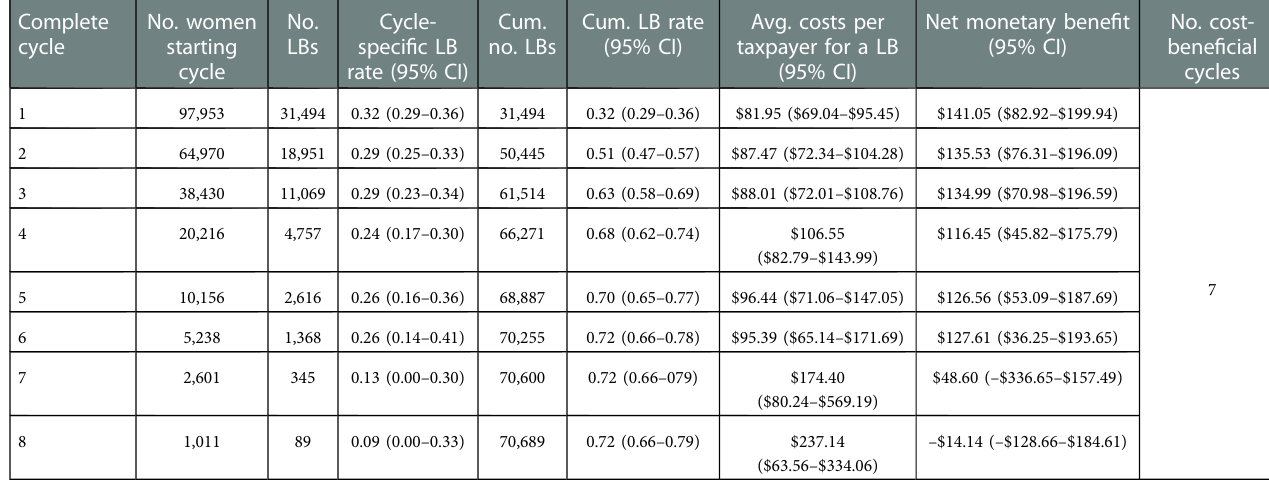
TABLE 3 Summary statistics for the base-case analysis of the cost-bene fi t analysis in 38 – 39-year-old women in the scenario where only women reaching oocyte pick-up and their costs were considered. Complete